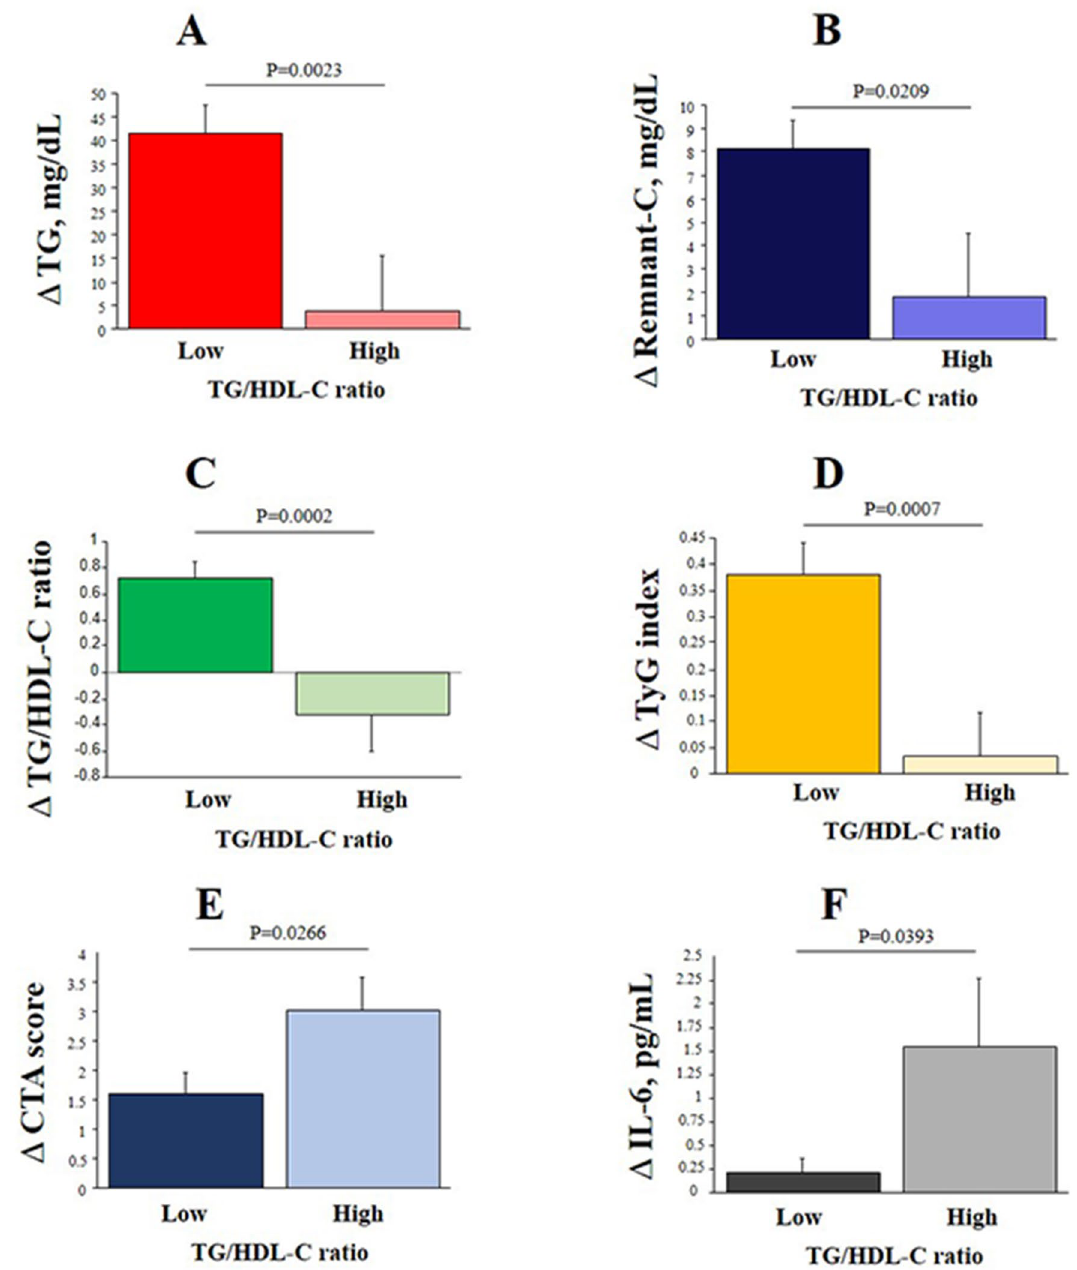
Figure 3. Association of TG/HDL-C ratio with progression of cardio-metabolic and CAD risk. Bar graphs represent ∆ changes (follow-up minus baseline) for the TGs ( A ), remnant-C ( B ), TG/HDL-C ratio ( C ), TyG index ( D ), CTA score ( E ), and IL-6 ( F ) levels from baseline to follow-up in two groups defined by baseline TG/ HDL-C ratio below (low) or above (high) the median